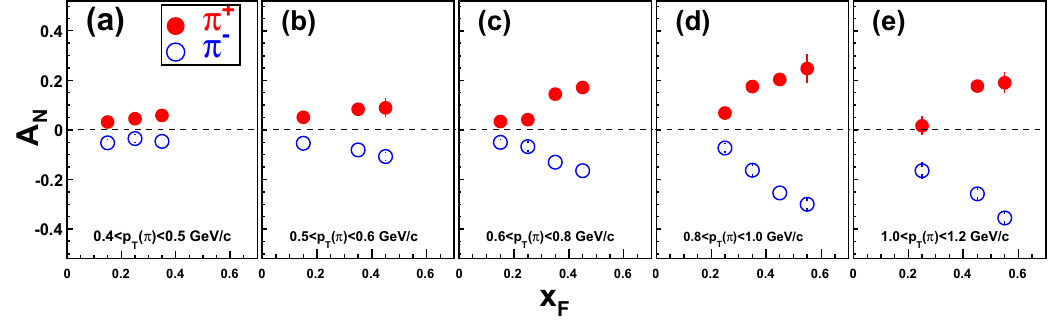
√ s = 62 GeV [18]. Large A N is observed when the π ± are produced in the forward